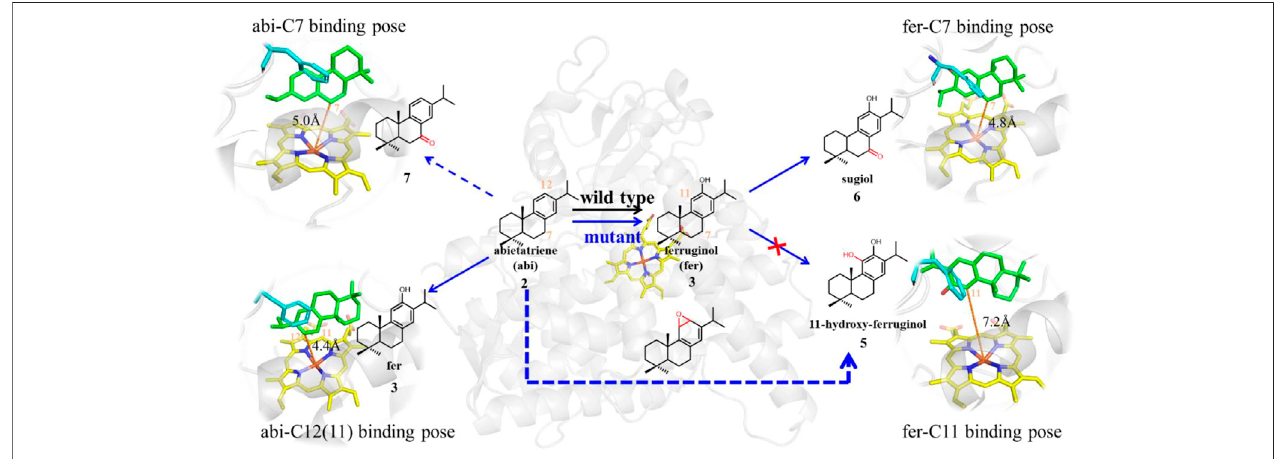
Frontiers in Chemistry |